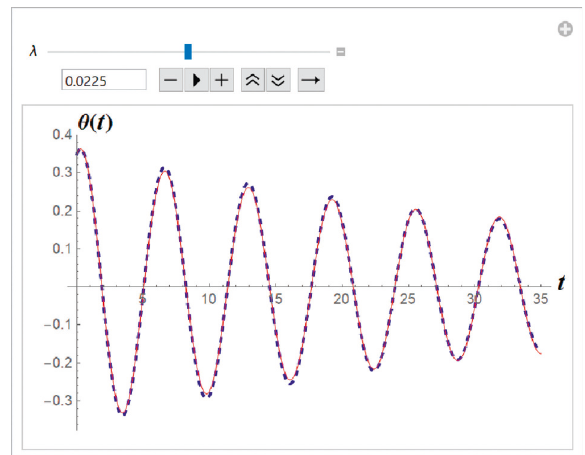
Figure 3: Comparison between the analytical approximant and the Runge–Kutta numerical solution for i.v.p. (61) with � − 0 . ρ � 0 . 0225 and c 0